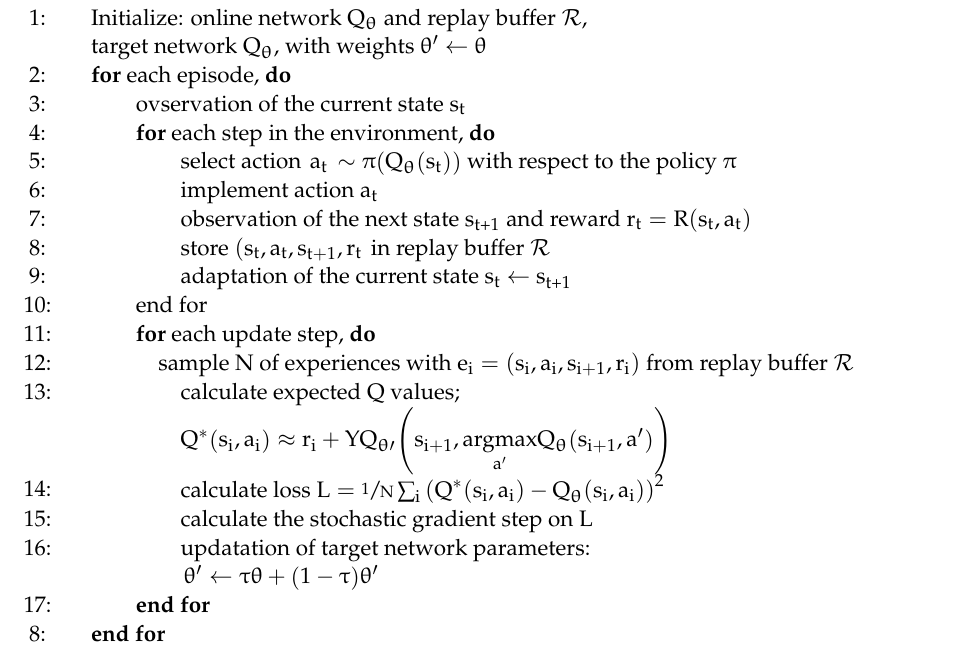
Algorithm 1. Double Deep Q-Networks Learning